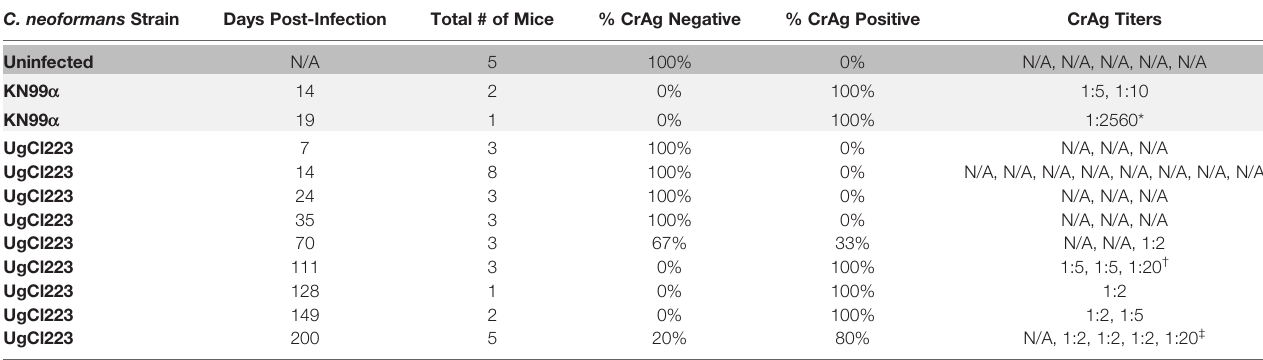
TABLE 2 | UgCl223-infected mice were CrAg negative until 70 days